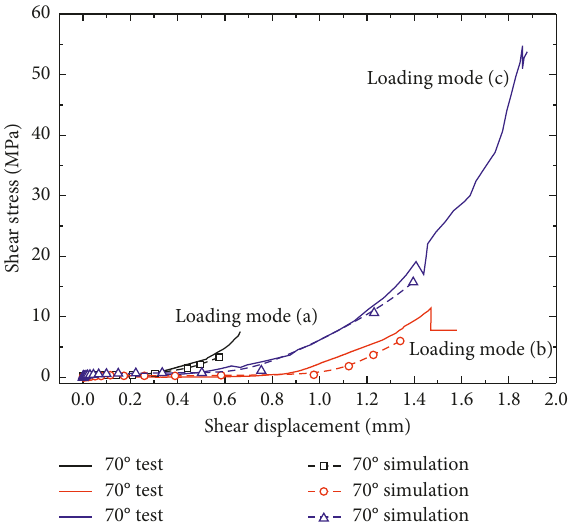
Figure 14: Comparison between test and simulation ( α � 70 ° ) under loading modes: (a), (b), and (c).